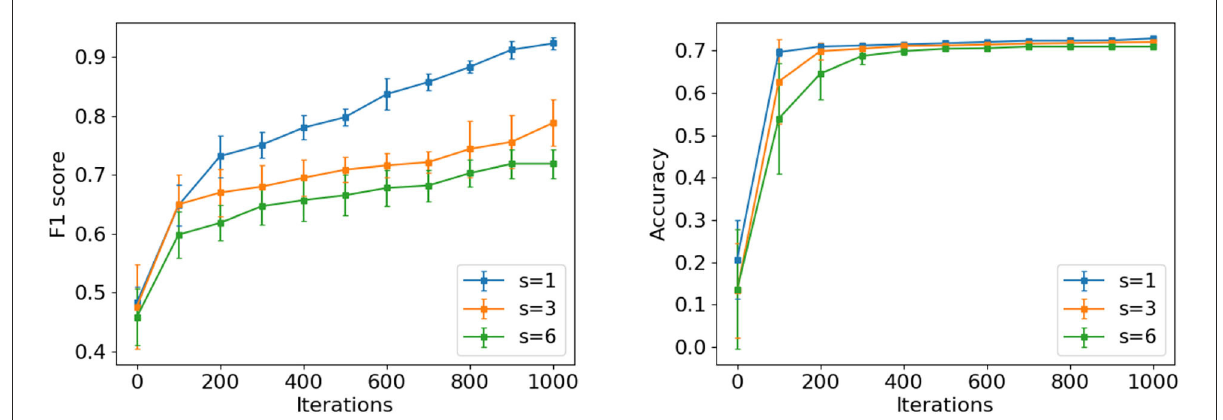
FIGURE5 The progression of top-10 averaged performance for AGNN under modification size s = 1,3, and 6 on PPI (left) and Citeseer (right) .